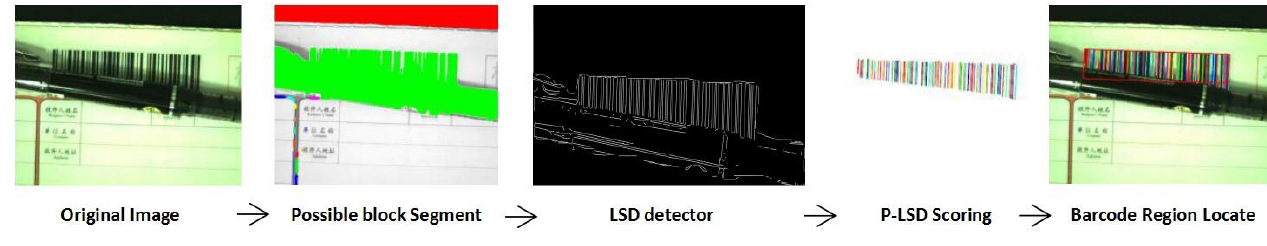
Figure3. Workflow of our method for locating possible barcode